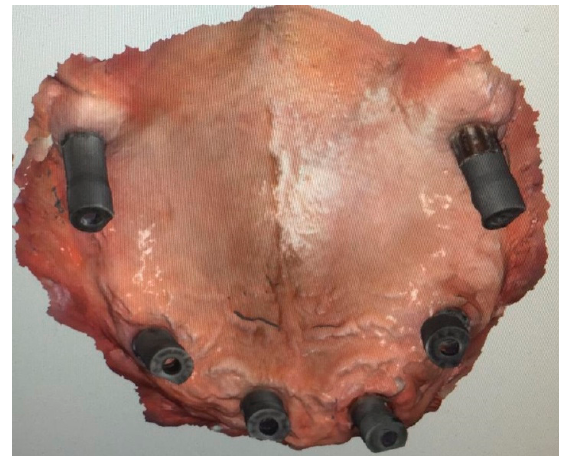
Figure 12. Final impression taken with Intra Oral Scanner (Medit i500, Seoul, South Korea) .